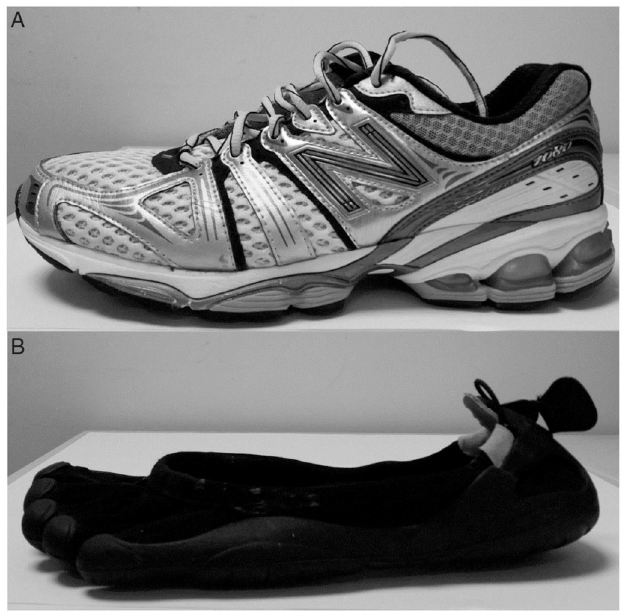
Figure 2. Experimental footwear ( A ) = conventional running shoes, ( B ) = minimal.